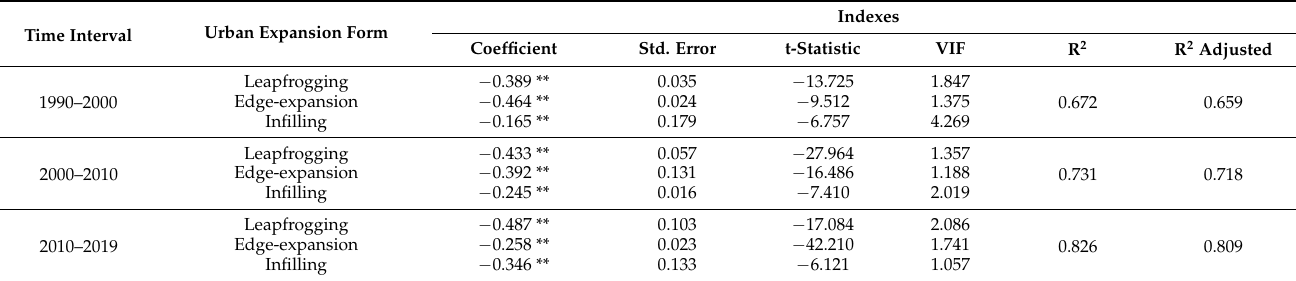
Table 8. The variance analysis results of the MLR model for the expansion intensity of urban expansion forms and the change in HQ in different time intervals.